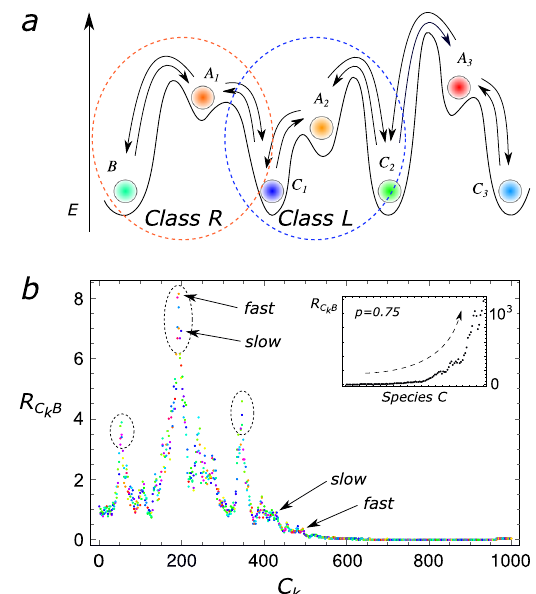
Fig. 3 Selection of states in a chain of three-state subsystems in a thermal gradient. a Chain of three concatenated three-state chemical networks, each similar to the one in Fig. 1a. The orange circle indicates a subsystem belonging to the class R , with the fast transition on the right branch, while the blue circle indicates a subsystem whose fast transition is ¼ P ð C Þ = P ð B Þ as a function of the states on the left branch (class L ). b R C k k B C k . The selection of states does not depend only on their transitions being fast or slow with respect to the neighboring reactions, but on all rates of the (cid:2) U ð½ 3 ; 6 (cid:3)Þ network. Here k B = 1, T = 0.7, Δ T = 0.2, Δ E k ~ U ([1, 10]), Δ ϵ ð i Þ slow (cid:2) U ð½ 2 ; 3 (cid:3)Þ , where U is the uniform distribution. Each subsystem and Δ ϵ ð i Þ fast belongs to class L with probability p = 0.5, and to class R with probability 1 − p . Inset — R C as a function of the species C k for the same parameters as k B in the main panel, but p = 0.75. The predominance of subsystems belonging to the class R leads to a directional exponential